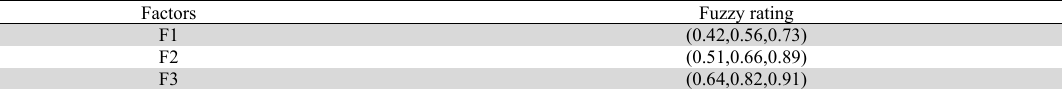
Average rating for each technological factor